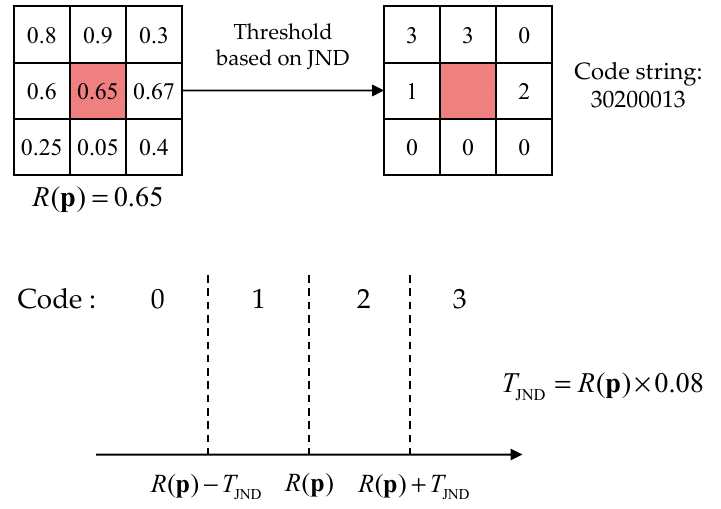
Figure 7. The process of human visual system (HVS)-based cost computation in a 3 × 3 local region.